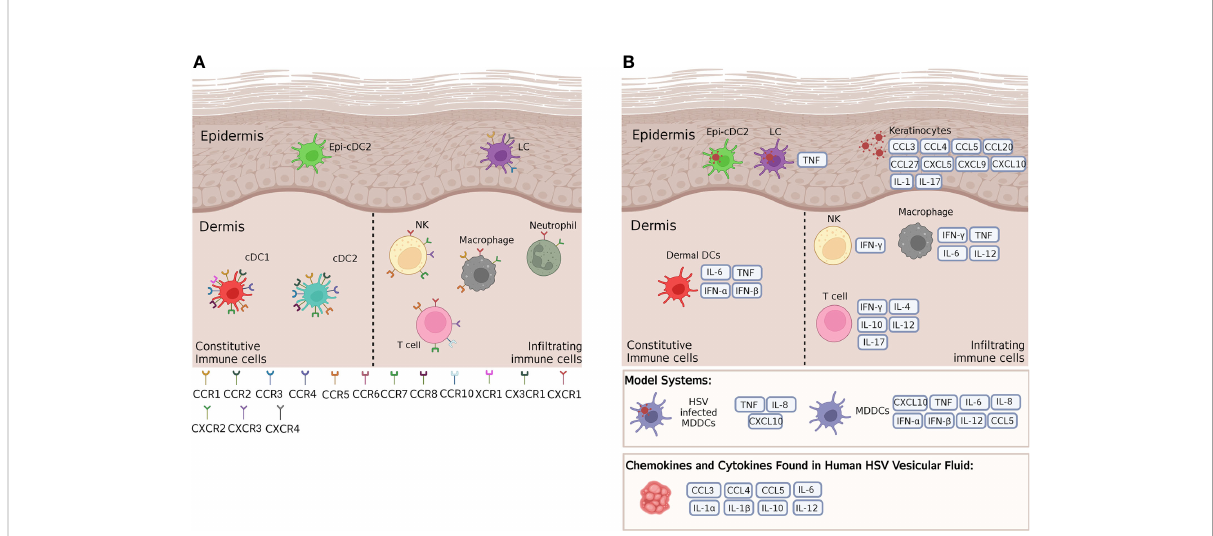
FIGURE 2 Cytokines and chemokines and their receptors expressed by key cutaneous and mucosal immune cells. (A) A wide range of chemokine receptors are expressed on cutaneous immune cells in steady state, in both murine and human mucosal tissues. These receptors respond to a variety of differing chemokines, some of which are crucial in HSV infection and immunity. (B) According to mouse and human cell culture models, HSV infected murine LCs produce TNF, while HSV infected MDDCs produce a variety of cytokines and chemokines such as TNF and CXCL10, and uninfected MDDCs alone have been shown to produce a variety of cytokines and chemokines. These models provide a guide to the cytokines and chemokines that human LCs, Epi-cDC2s and dermal DCs may produce in response to HSV infection in the skin. In the epidermis, infected keratinocytes produce many cytokines and chemokines that attract in fi ltrating cells to the site of infection. In the dermis, murine dermal DCs have been shown to produce IL-6, TNF and Type I IFNs, while resident and in fi ltrating immune cells such as NK cells, T cells and macrophages produce a plethora of cytokines and chemokines in response to HSV infection of other immune cells. Many of these same cytokines and chemokines have also been found in human HSV vesicular fl uid. For further details of which cytokines and chemokines are produced by human and/or murine models please refer to Table